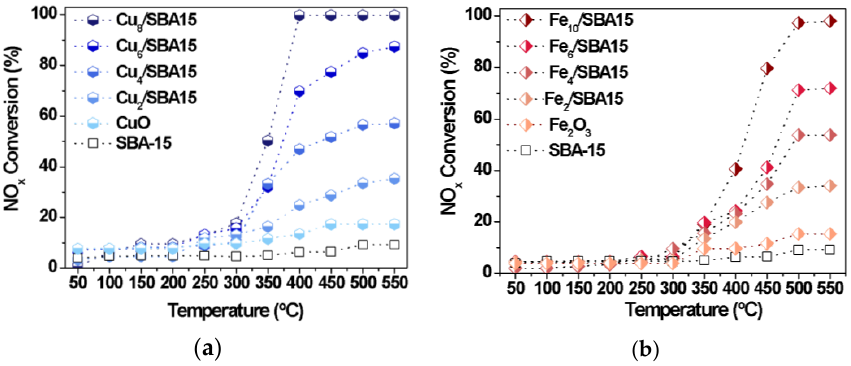
Figure 6. NO x conversions as a function of the temperature. ( a ) Cu x /SBA-15 and ( b ) Fe x /SBA-15 series of solids.